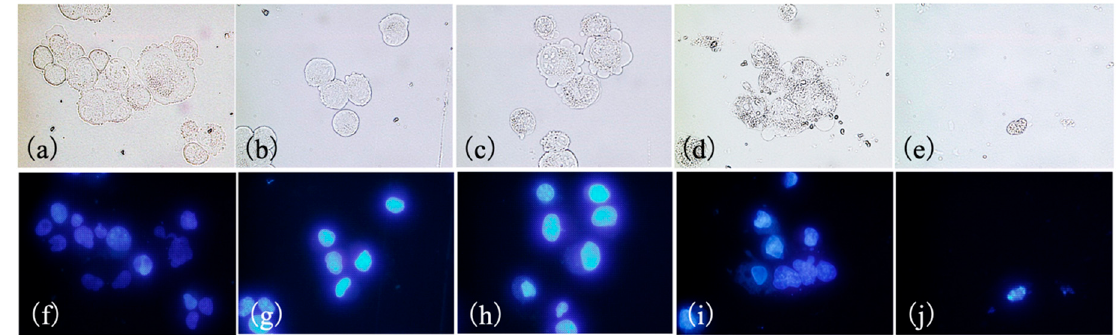
Figure5. MorphologicalchangesinSNPcells4hafterphotodynamictherapy(PDT)withglucose-conjugated Figure 5. Morphological changes in SNP cells 4 h after photodynamic therapy (PDT) with glucose- chlorin e6 (G-Ce6). The cells were incubated with 10 µ g / mL G-Ce6 for 24 h. After washing with fresh conjugated chlorin e6 (G-Ce6). The cells were incubated with 10 μ g/mL G-Ce6 for 24 h. After washing media, the cells were irradiated with 650-nm laser light (10 mW / cm 2 ; 0, 1, 5, and 15 J / cm 2 ). ( a,f ) Control, with fresh media, the cells were irradiated with 650-nm laser light (10 mW/cm 2 ; 0, 1, 5, and 15 J/cm 2 ). ( b,g ) 0 J / cm 2 , ( c,h ) 1 J / cm 2 , ( d,i ) 5 J / cm 2 , ( e,j ) 15 J / cm 2 . Upper panel: transmitted light images (a–e). Lower ( a,f ) Control, ( b,g ) 0 J/cm 2 , ( c,h ) 1 J/cm 2 , ( d,i ) 5 J/cm 2 , ( e,j ) 15 J/cm 2 . Upper panel: transmitted light panel: fluorescence images (f–j). The cells were stained with Hoechst 33342 dye 4 h after laser irradiation. No signs of apoptosis were observed in the control and 0 J / cm 2 PDT groups ( a , b ). In the 1 J / cm 2 PDT group, the cells showed membrane blebbing ( c ). In the 5 J / cm 2 PDT group, the cells showed shrinkage ( d ). Cells in the 5 and 15 J / cm 2 PDT groups displayed nuclear condensation ( i , j